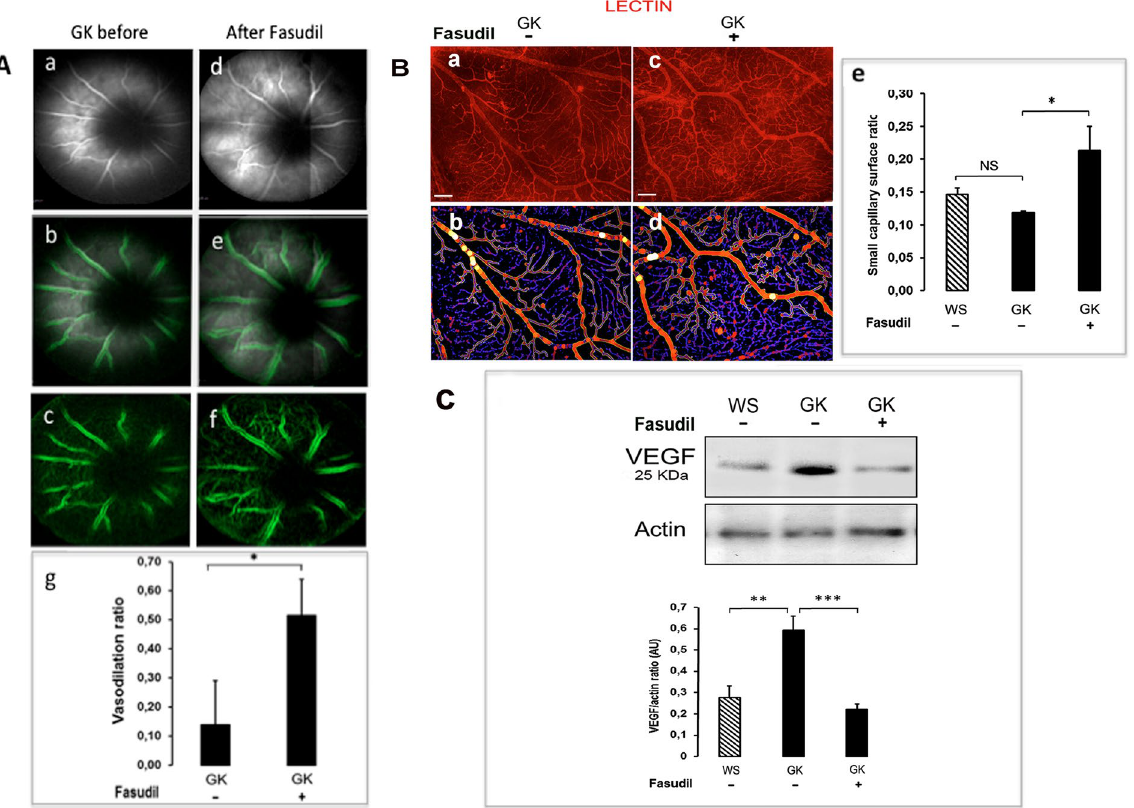
Figure 8. Effect of intravitreal fasudil on GK rat retinal vessel dilation. ( A ) Confocal in vivo fluorescein angiography before and after fasudil treatment allowed visualization of retinal vessels (a–d). Edge detection was performed using a dedicated macro (b–e,c–f) and vascular diameter before and after treatment determined a vasodilation ratio (g) showing significant effect of fasudil on retinal vessel diameter (p < 0.05). ( B ) An automated detection of retinal capillary network surface was performed on retinal flat-mounts stained by TRITC-lectin (red) to highlight the vessel walls in vehicle and Fasudil treated GK rats (small vessels represented in blue and large vessels in red) (a–b and c–d). The retinal surface coverage by small vessels was significantly increased in fasudil treated GK rats as compared to vehicle treated GK rats (n = 4–5 per group, p < 0.05) consistent with a vasodilation of retinal capillaries (e). ( C) Western blot showed a significant decrease in the VEGF-164 level in the neural retina of fasudil treated GK rats as compared to vehicle treated GK rats, suggesting decreased retinal hypoxia in fasudil treated retina (n = 8 per group). * p value < 0, 05; ** p value < 0, 01 *** p value <